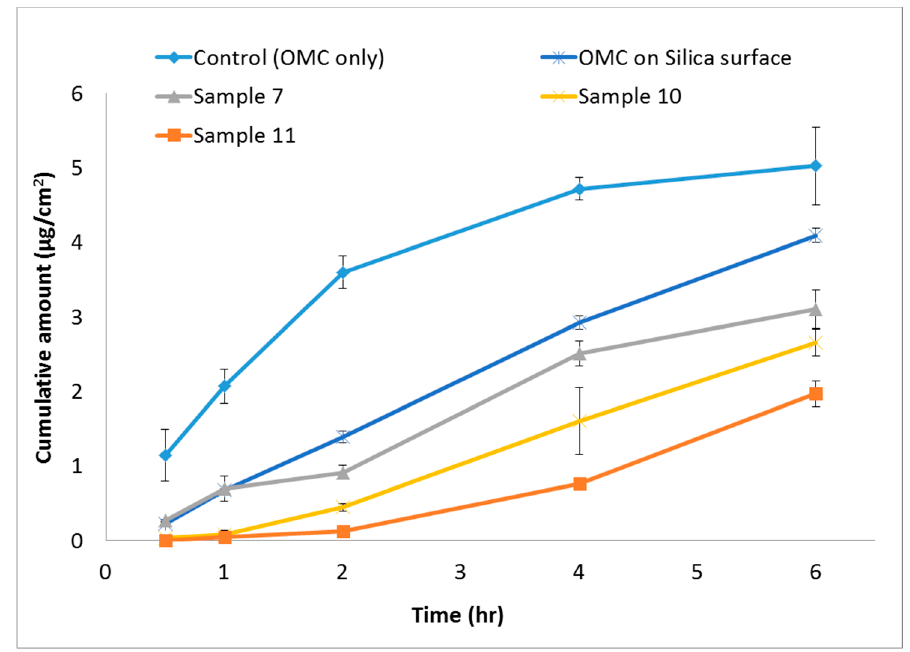
Figure 4. Release profile of OMC from OMC/SiO 2 nanoparticles.